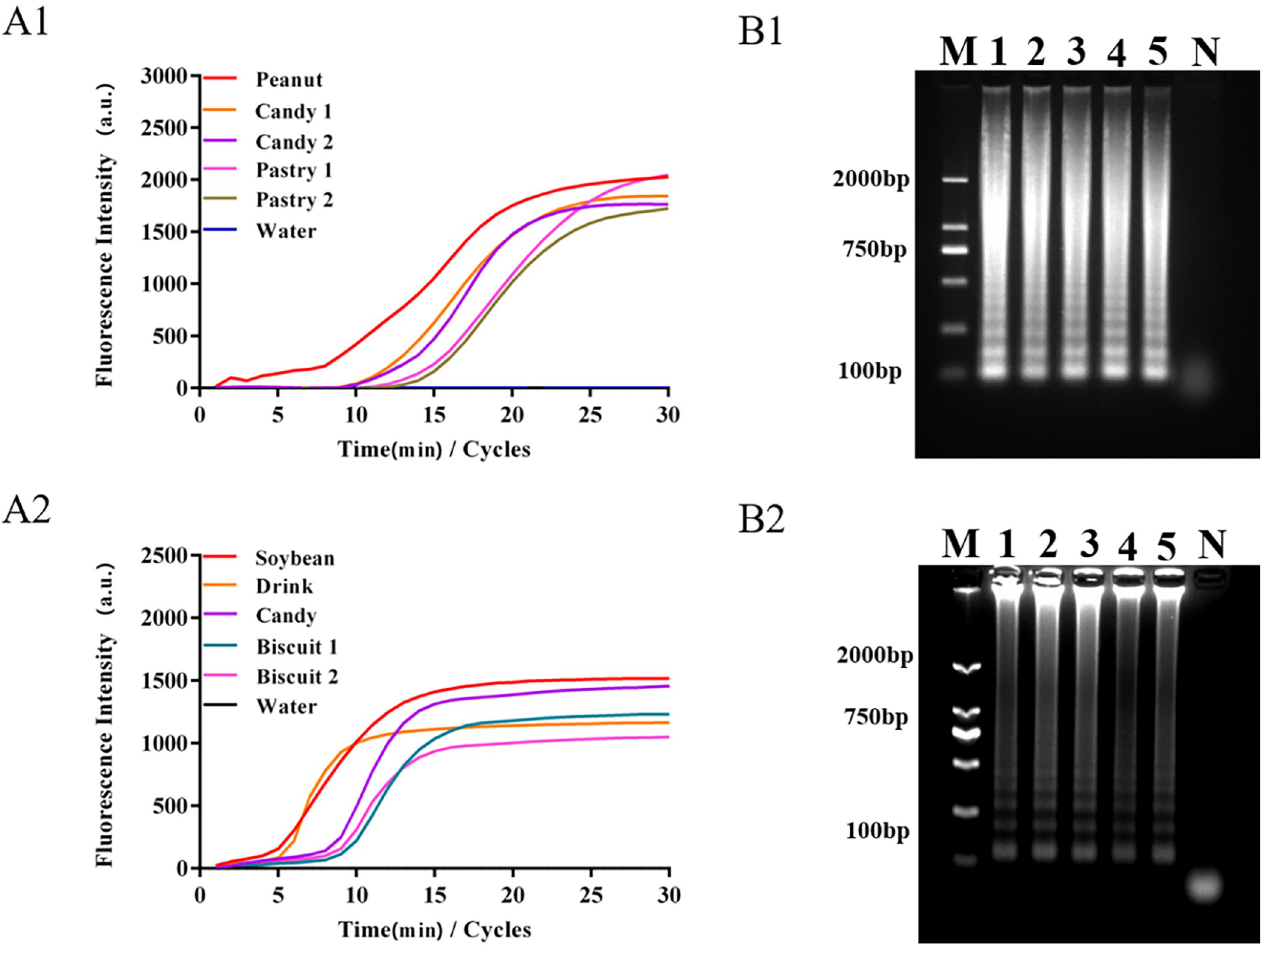
Fig 9. Detection of peanut and soybean allergens in commercial products. Notes: A1 & A2, LAMP amplification curves of different products containing peanut and soybean; B1 & B2, corresponding ladder electrophoresis bands o of different products containing peanut and soybean.